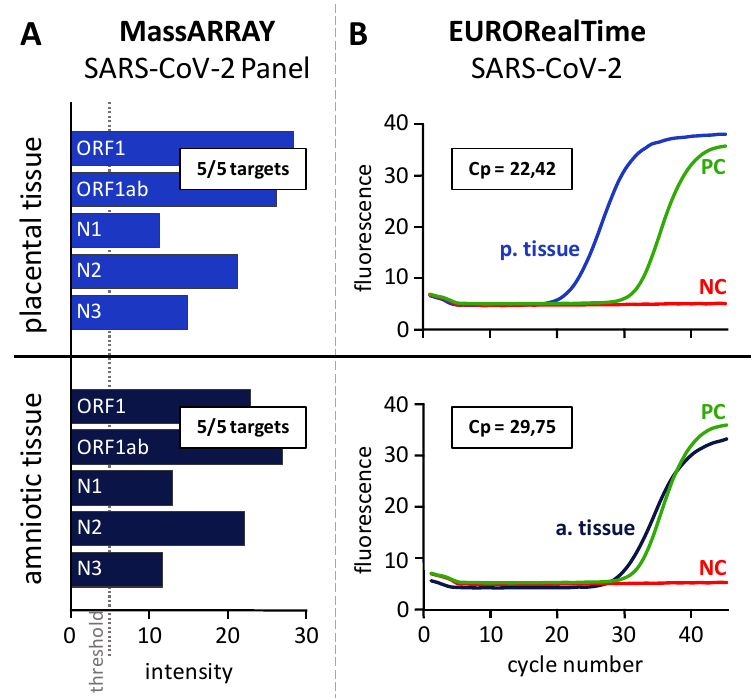
Figure 4. Detection of SARS-CoV-2 RNA in placental and amniotic tissue. Placental and amniotic tissue were analyzed by MALDI-TOF MS using the CE-IVD-certified MassARRAY SARS-CoV-2 Panel ( A ) and by RT-PCR using the EURORealTime SARS-CoV-2 Kit ( B ). ( A ): The plots display the intensity of the peaks corresponding to the 5 targets ORF1, ORF1ab, N1, N2 and N3 included in the CE-IVD-certified MassARRAY SARS-CoV-2 Panel. The intensity threshold considering a peak as detected is 5. All 5 SARS-CoV-2 targets were detected in both placental and amniotic tissue. ( B ). The graphs show the fluorescence intensity ( y -axis) for each cycle ( x -axis) of the real-time amplification of the SARS-CoV-2 -specific target regions (amplification curve). The amplification curve of the positive control (PC) is highlighted in green, the one of the negative control (NC) in red. The crossing point (Cp) value is indicated for both placental tissue (p.tissue) and amniotic tissue (a.tissue).